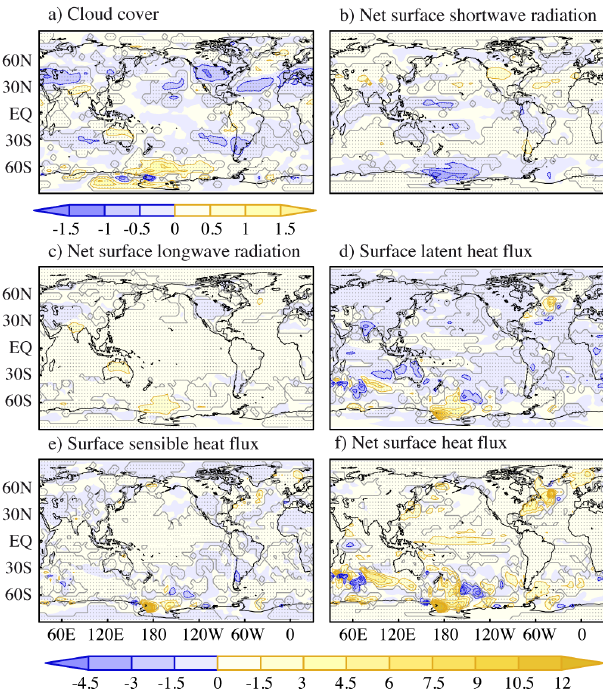
Fig. 8. In-phase regression patterns in FOR2 between the standard- ised total radiative forcing and (a) the total cloud cover (in %), (b–f) the different components of the net surface heat flux (in Wm − 2 ). Note that positive heat flux values indicate that the flux goes into the ocean. Significance is addressed as in Fig.